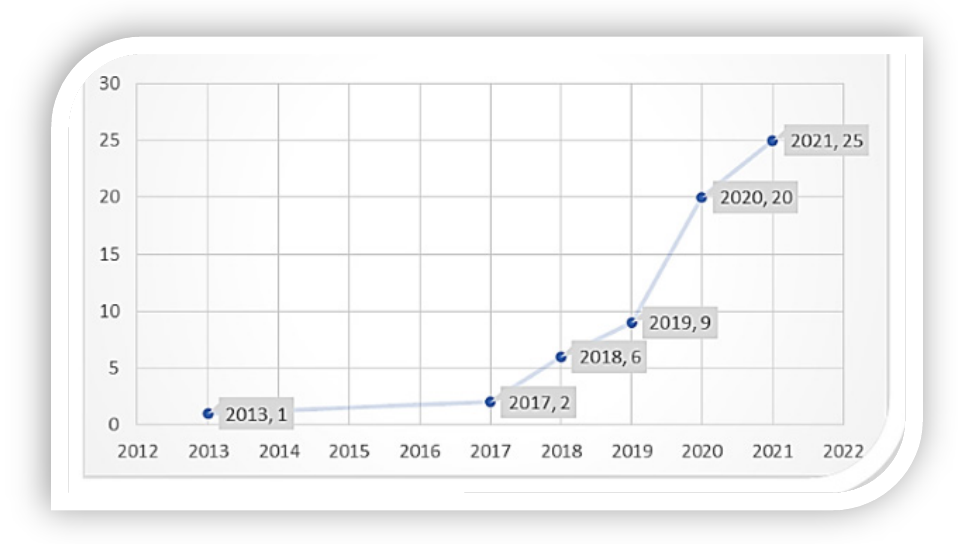
Figure 2. Publication Trajectory (year-wise).